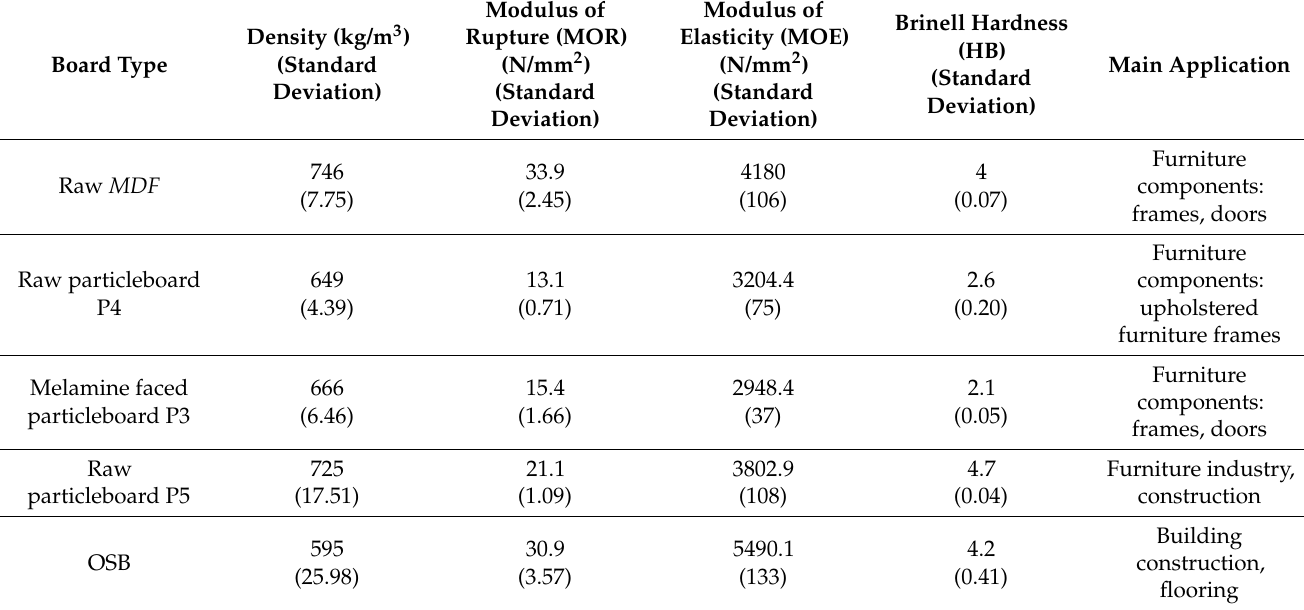
Table 1. Detailed Information about the standard Wood-Based Boards which were tested.